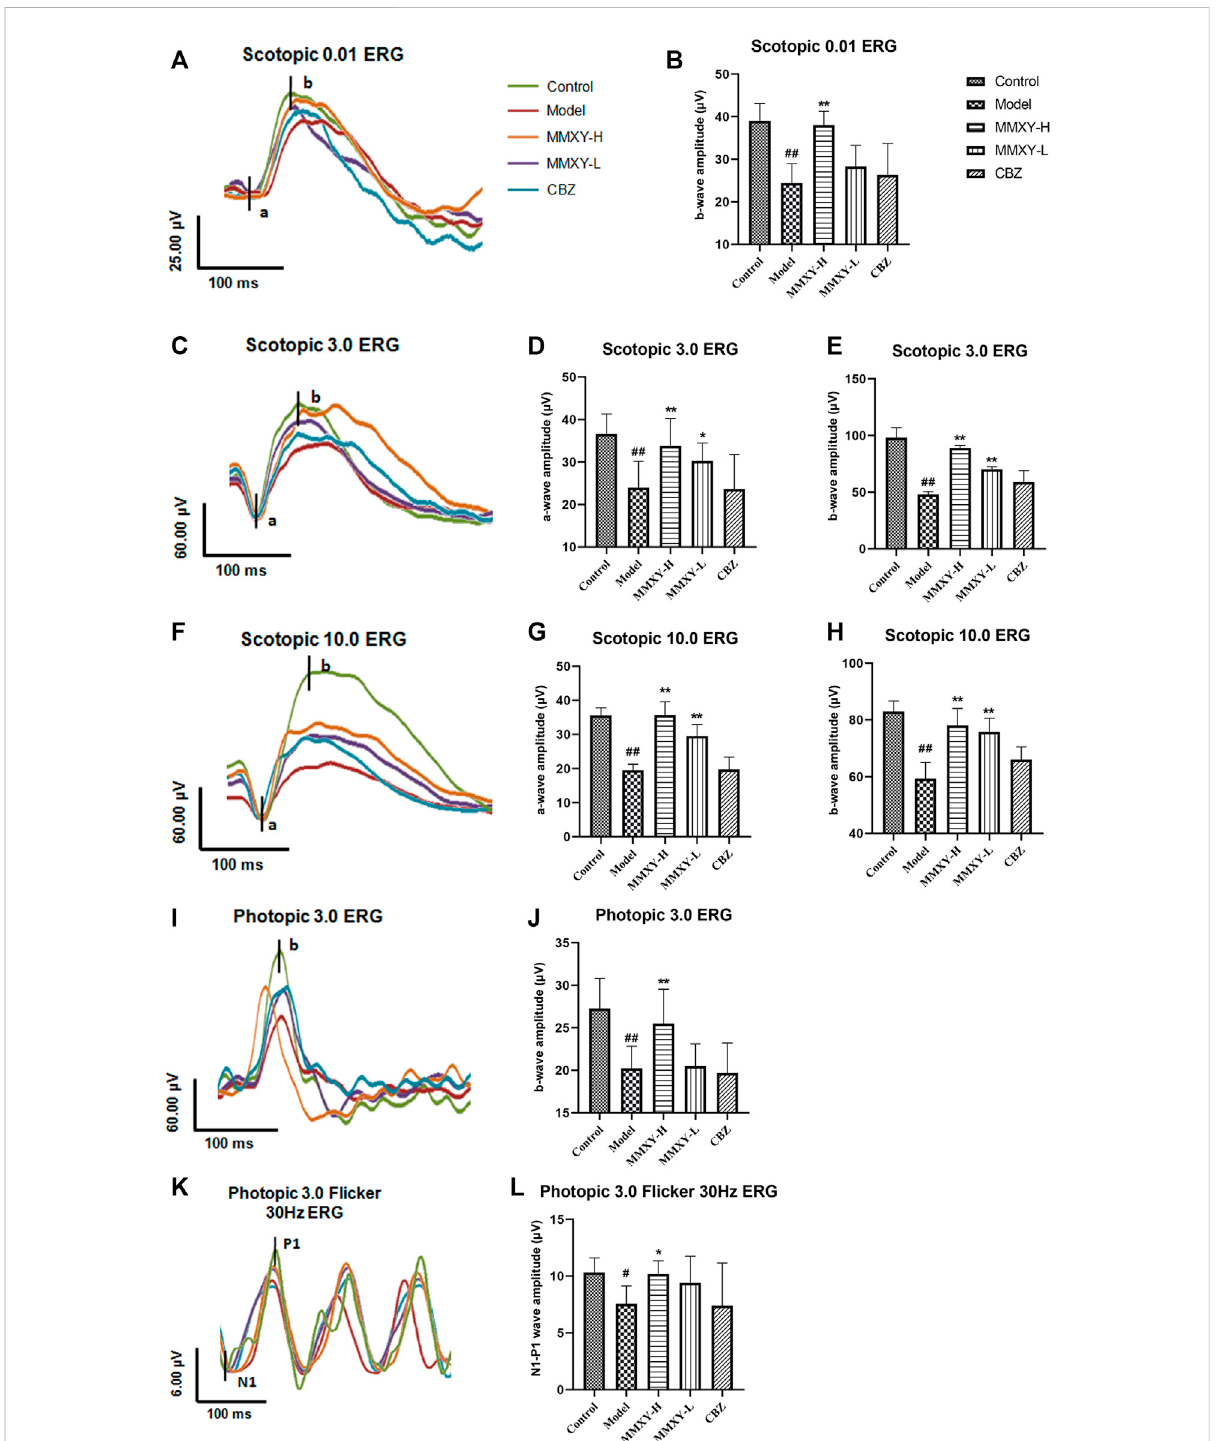
FIGURE 7 Effects of MMXY on ERG of CUMS rats in each group. (A) The waveform curve of Scotopic 0.01 ERG. (B) The b-wave amplitude of Scotopic 0.01 ERG (n = 8). (C) The waveform curve of Scotopic 3.0 ERG. (D,E) The a- and b-wave amplitudes of Scotopic3.0 ERG (n = 8). (F) The waveform curve of Scotopic 10.0 ERG. (G,H) The a- and b-wave amplitudes of Scotopic10.0 ERG (n = 8). (I) The waveform curve of Photopic 3.0 ERG. (J) The b-wave amplitude of Photopic 3.0 ERG (n = 8). (K) The waveform curve of Photopic 3.0 fl icker 30 Hz ERG. (L) The N1-P1 wave amplitude of Photopic 3.0 fl icker30 Hz ERG (n = 8). In the waveform curve, the length of the horizontal scale represents time (25-100 ms), and the length of the longitudinal scale represents amplitude (4-60 μ V). Different colors represent different groups. Results are shown as the mean ± SD. # p < 0.05 and ## p < 0.01 vs. control group; * p < 0.05 and ** p < 0.01 vs. model